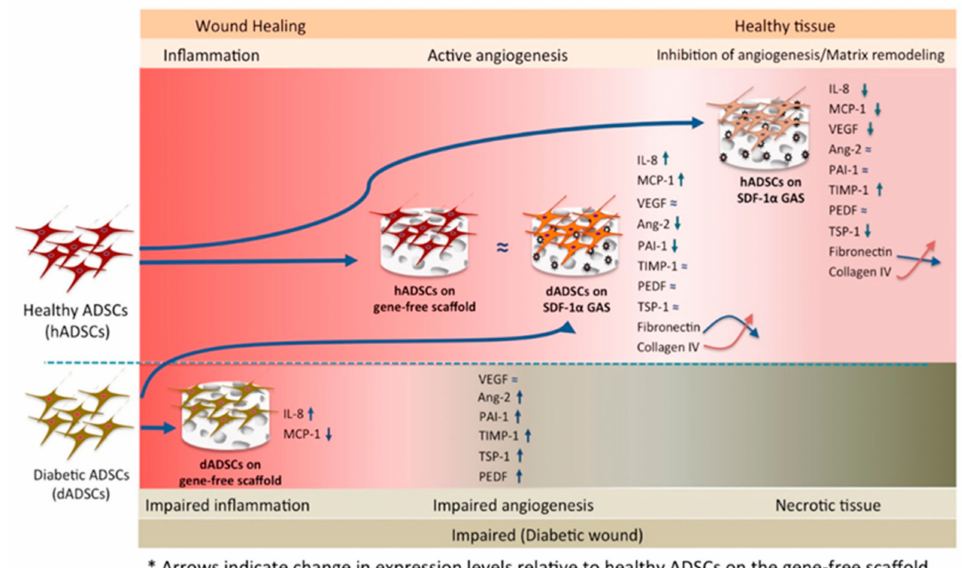
Figure 7. A schematic of the functional changes induced by the SDF-1 α gene-activated collagen scaffold in healthy and diabetic ADSCs. The diabetic ADSCs on the gene-free scaffold initially showed an impaired functional response characterized by elevated inflammatory cytokine production (IL-8), anti-angiogenic factors (PAI-1, TIMP-1, PEDF and TSP-1) and vascular destabilizing factor Ang-2 compared to the healthy ADSCs on the gene-free scaffold. However, when activated within the gene-activated scaffold, the impaired signaling in the diabetic ADSCs could be restored to a healthy-like state and exert therapeutic paracrine effects capable of enhancing angiogenesis. Meanwhile, the gene-activated scaffold drove the healthy ADSCs towards an advanced cellular maturation stage while facilitating the bypass of early signaling events such as the production of uPA, VEGF and MCP-1 and the deposition of the provisional matrix